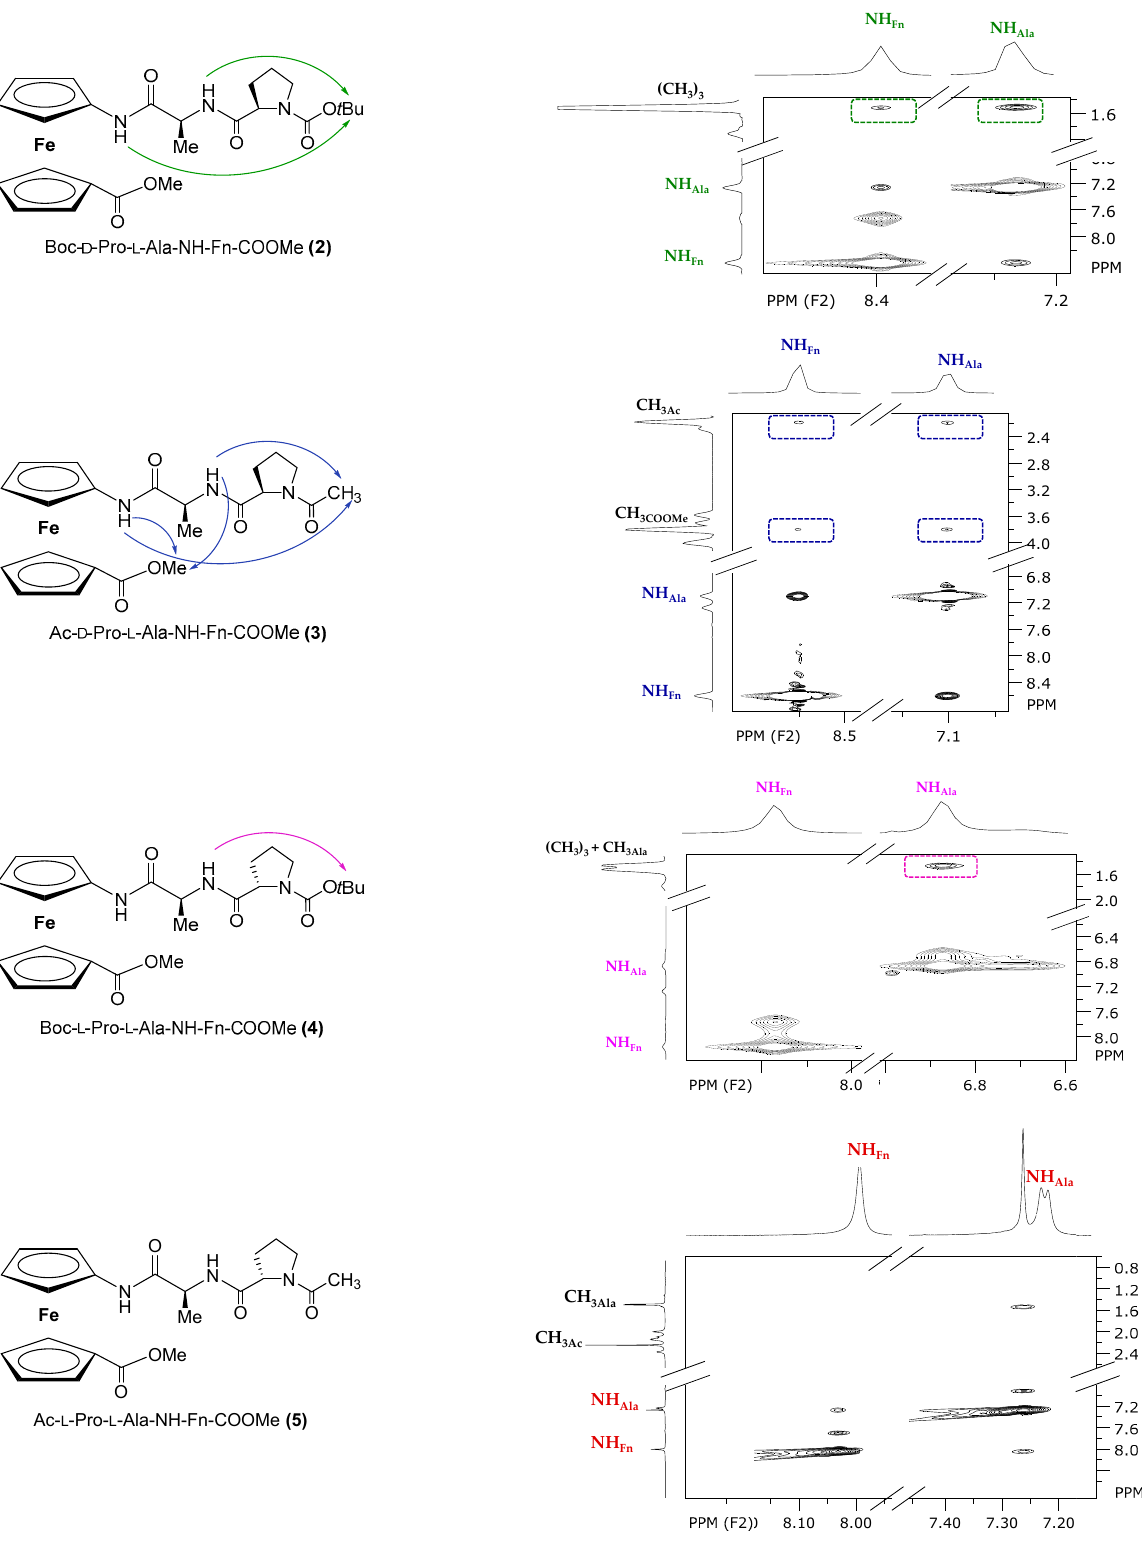
Figure 10. The intrastrand NOE contacts in the spectra of conjugates 2 – 4 and interstrand NOE contacts in the spectrum of conjugate 3 are depicted with arrows. The NOE contacts attributed to intra- and/or intrastrand HBs are not observed in spectrum of conjugate 5 .